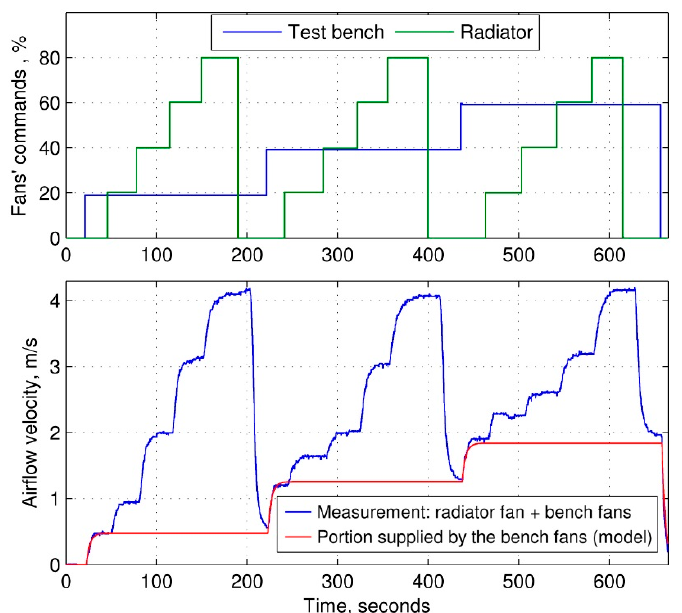
Figure 8. Estimation of the airflow supplied by the test bench fans when the radiator’s fan is